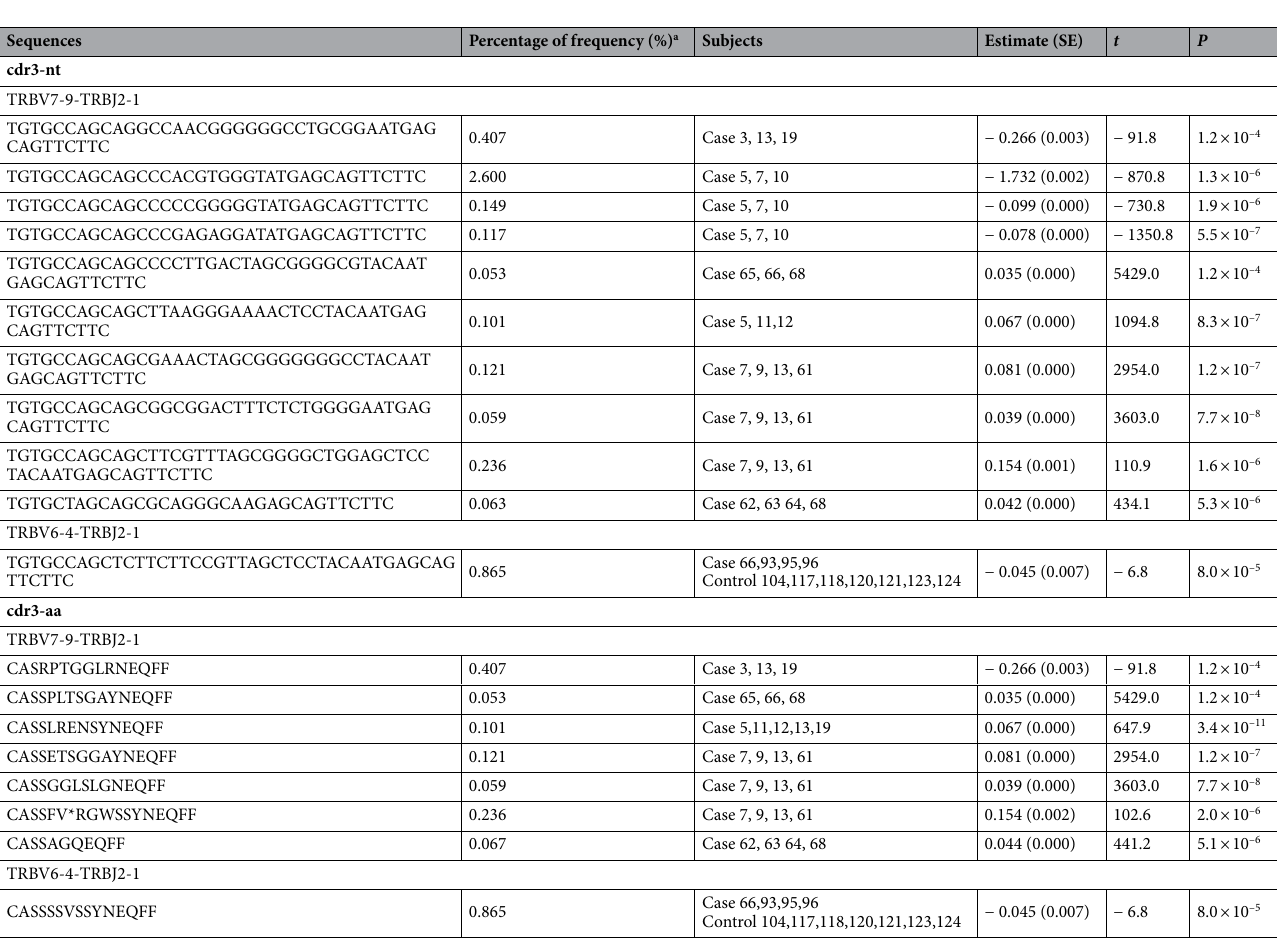
Table 3. OMDT severity-associated TCR β-chain CDR3 sequences. OMDT, occupational medicamentosa- like dermatitis due to trichloroethylene; SE, standard error. Linear regression of sequence frequencies with decreasing OMDT severity from acute to recovery stage. a Percentage of frequency of the sequence in the total frequency of corresponding TRBV-TRBJ